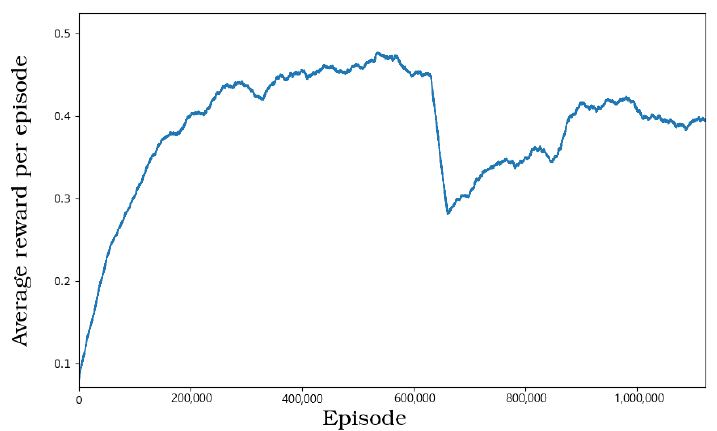
Figure 7. The total rewards generated during the learning process. The graph presents the values of an average number of tasks completed by the agent through the learning process, clearly visualising the achieved improvements over time—even though the agent performance tumbled in the middle of the learning process due to high variation of the losses.